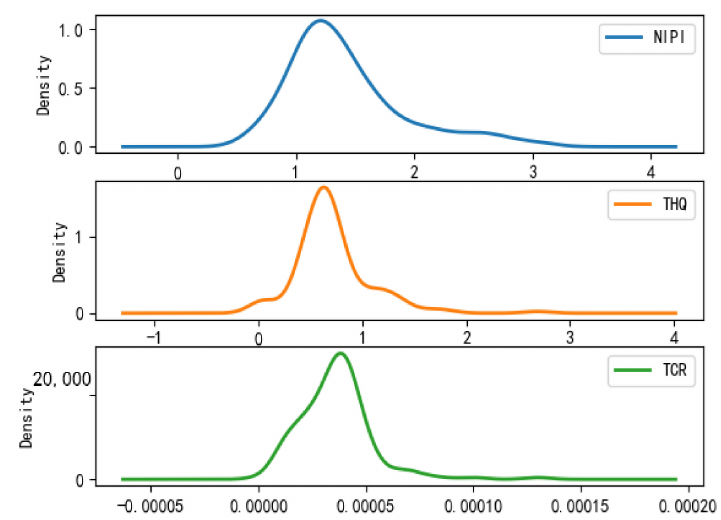
Figure 9. Plot of probability density function of Category 2.